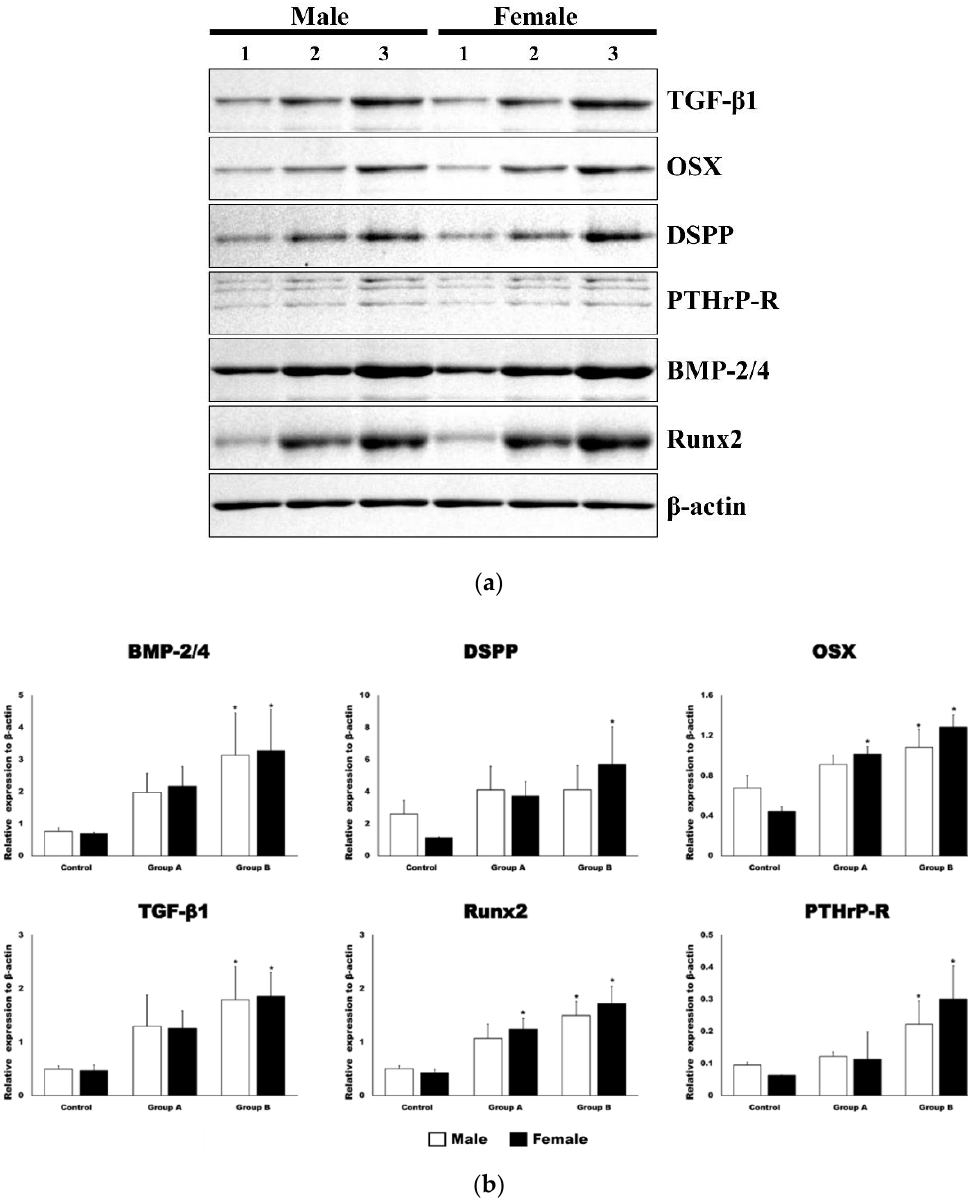
Figure 3. Western blot results with tissue samples. ( a ) Representative blot images after 4HR administration (1: Control, 2: Group A, 3: Group B). The latter increased the expression of TGF- β 1, OSX, DSPP, BMP-2 / 4, Runx2, and PTHrP-R. ( b ) Relative level of protein expression was calculated with reference to that of β -actin. Compared to control group, Group B showed a significantly higher level of expression (* p < 0.05).